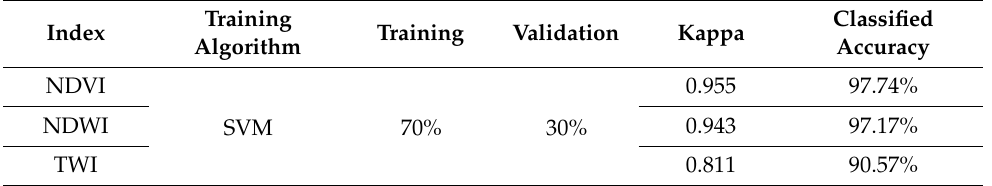
Table 2. The index classification results by using the SVM algorithm of Dzetsaka classification tool.